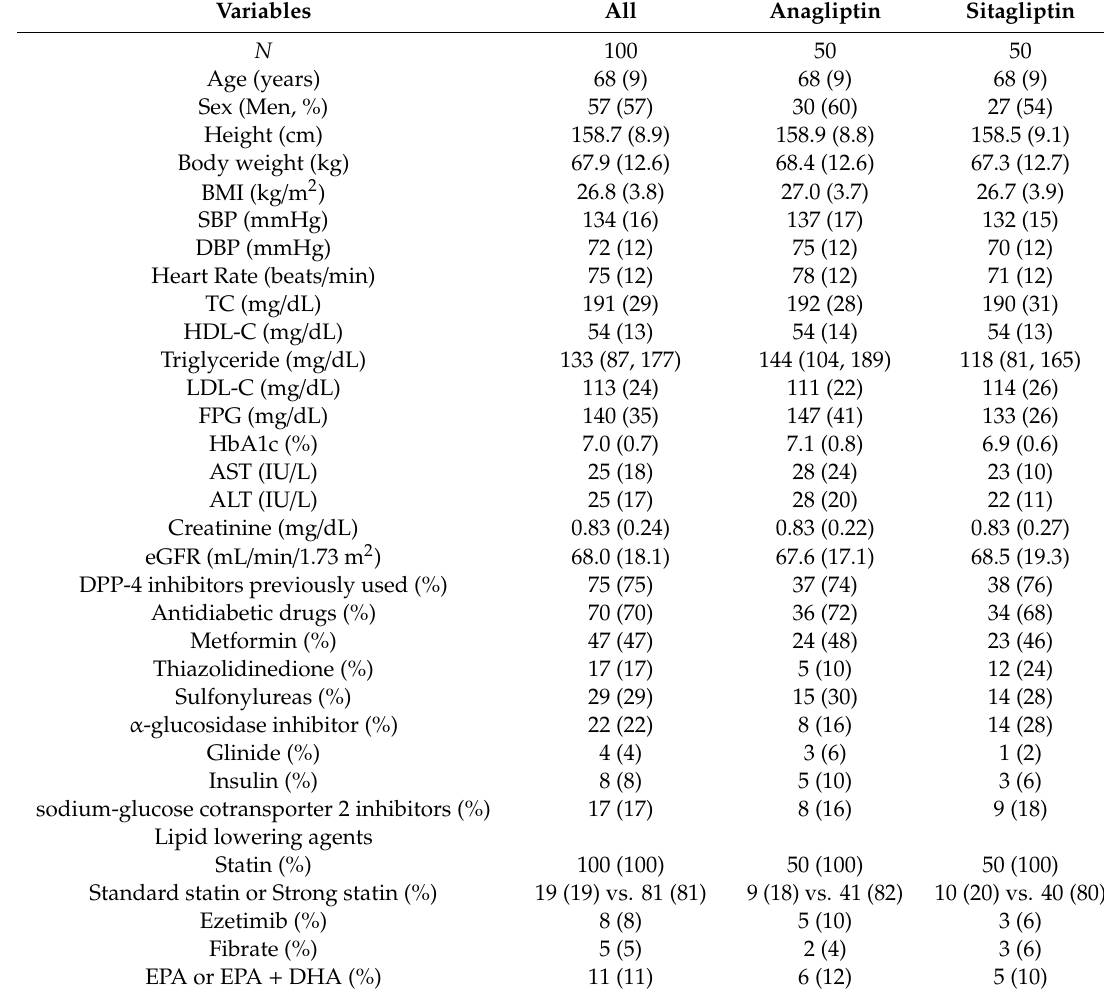
Table 1. General